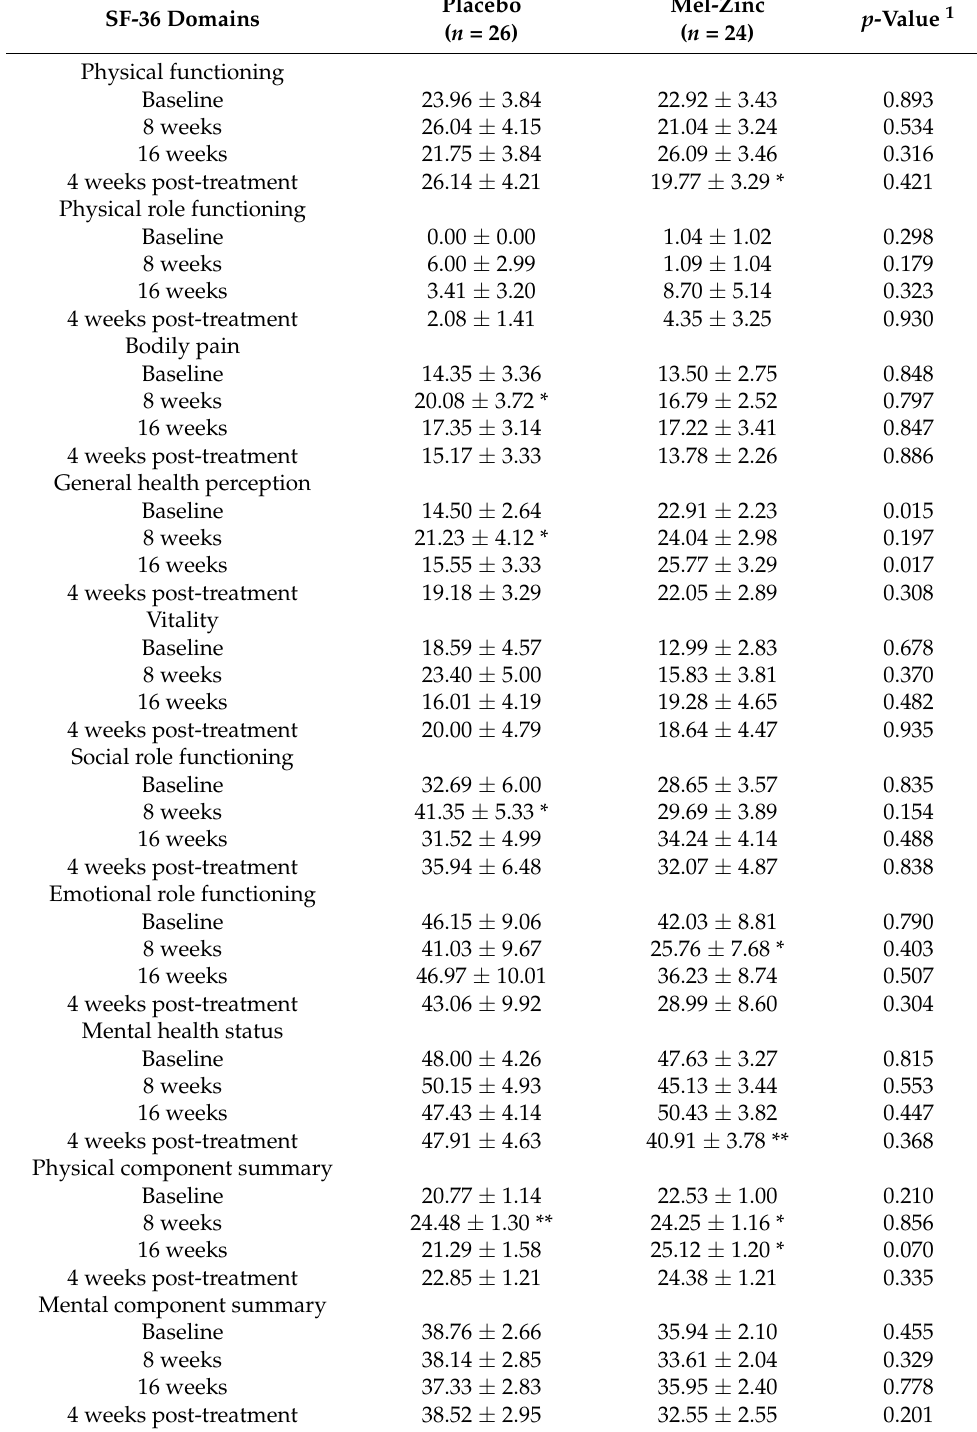
Table 2. Health-related quality of life (SF-36 questionnaire) in participants completing final assess-